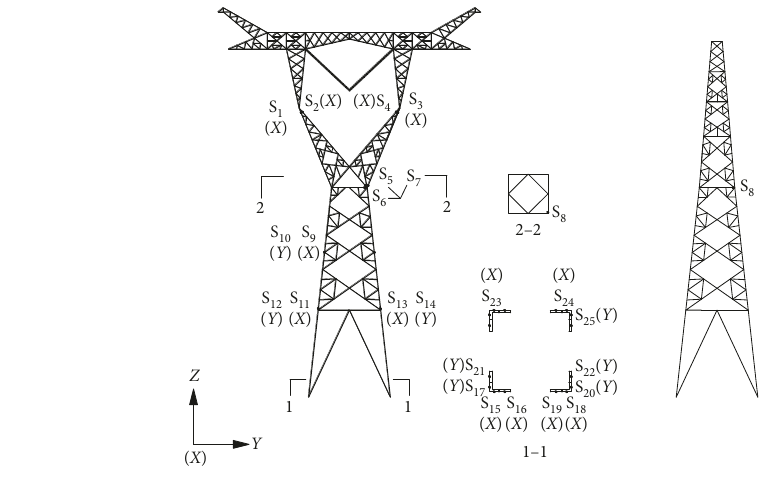
Figure 14: Layout of strain gauges.